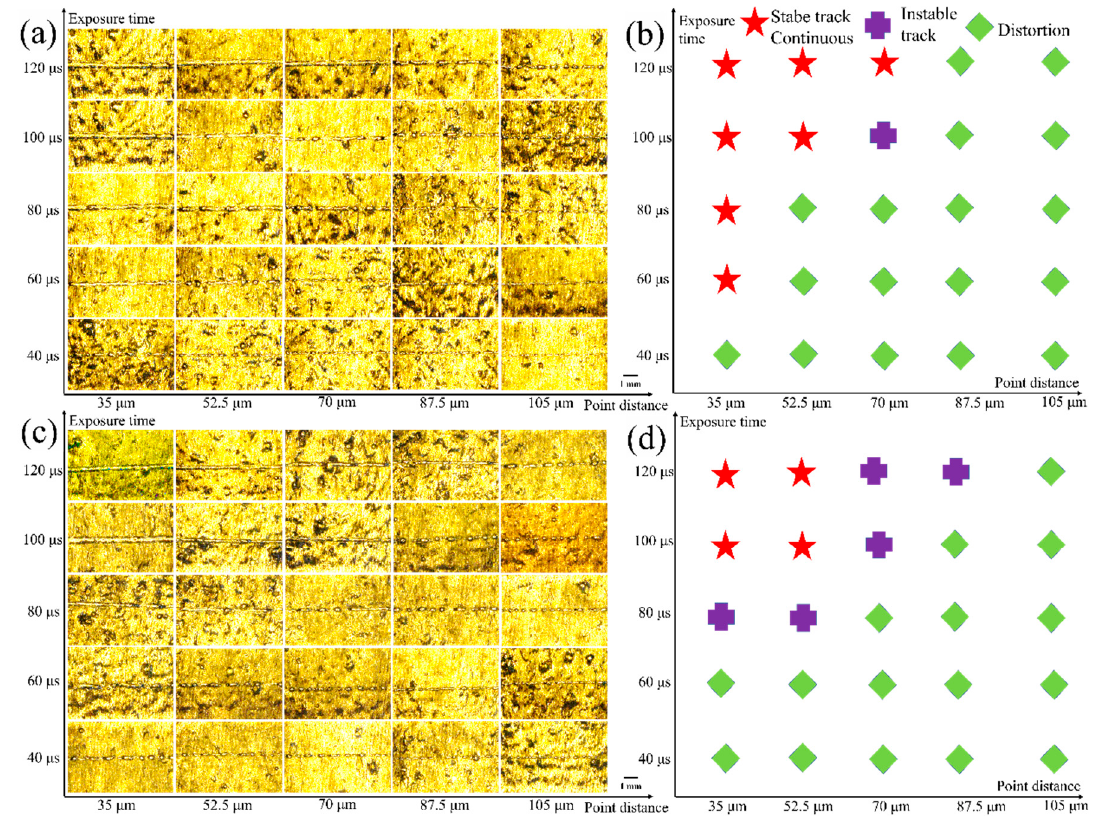
Figure 2. The single-track experiments ( a ) surface morphologies with a power of 300 W and a layer thickness of 50 μ m; ( b ) process results of ( a ); ( c ) surface morphologies with a power of 300 W and a layer thickness of 150 μ m; ( d ) process results of ( c ).